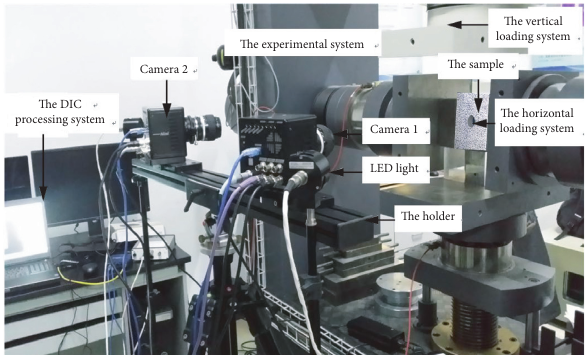
Figure 3: The Rock Biaxial Loading and Macro-Mesoscopic Measurement System.